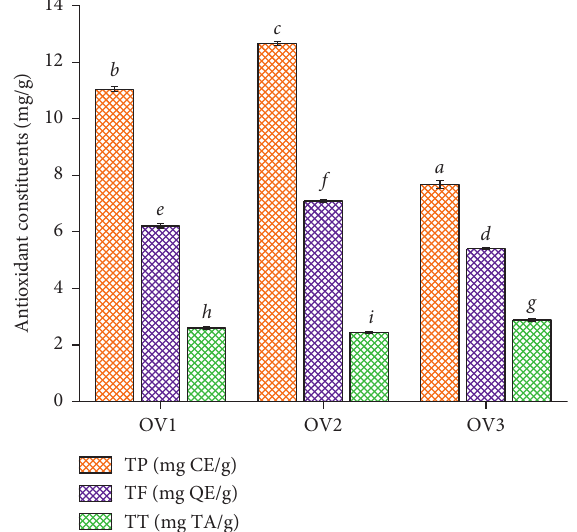
Figure 4: Total antioxidant constituents, i.e., phenolics, flavonoids, and tannins, in alcoholic (ALC) extracts of Origanum vulgare from different locations, i.e., Auli (OV1), Pithoragarh (OV2), and Haldwani varied from 23.48 to 98.86 mg GAE/g and 14.45 to 19.53 mg quercetin/g, respectively [46].